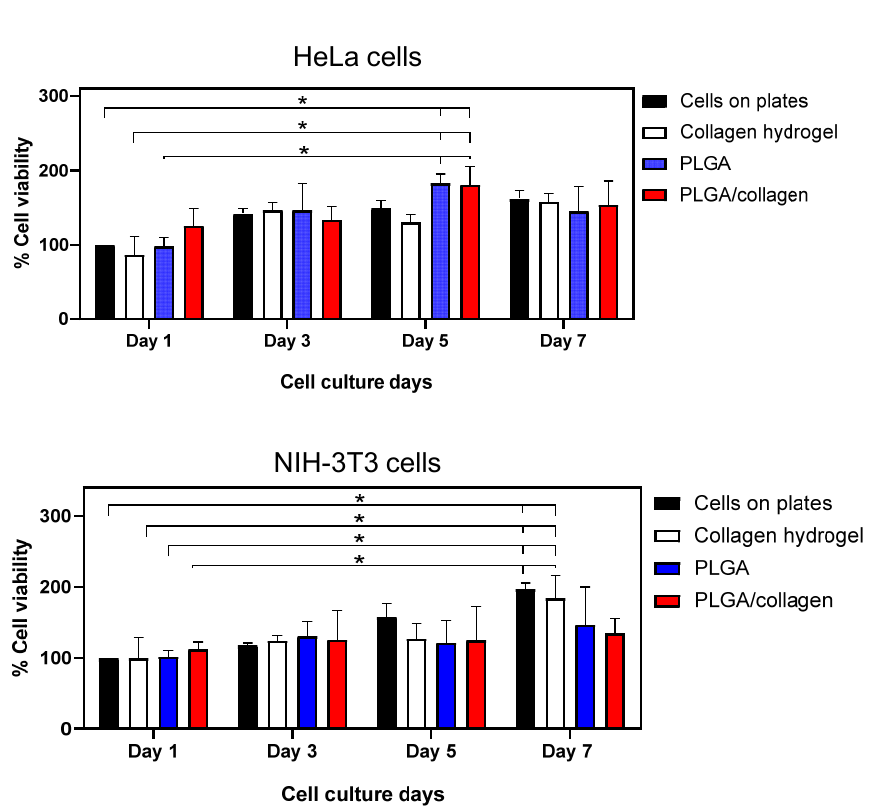
Figure 10. MTT test of cell viability using HeLa cells and NIH-3T3 fibroblasts on a positive control, collagen hydrogel, PLGA, and PLGA/collagen scaffolds at different exposure times, 1, 3, 5, and 7 days. (* denotes a significant difference with a value p < 0.05).